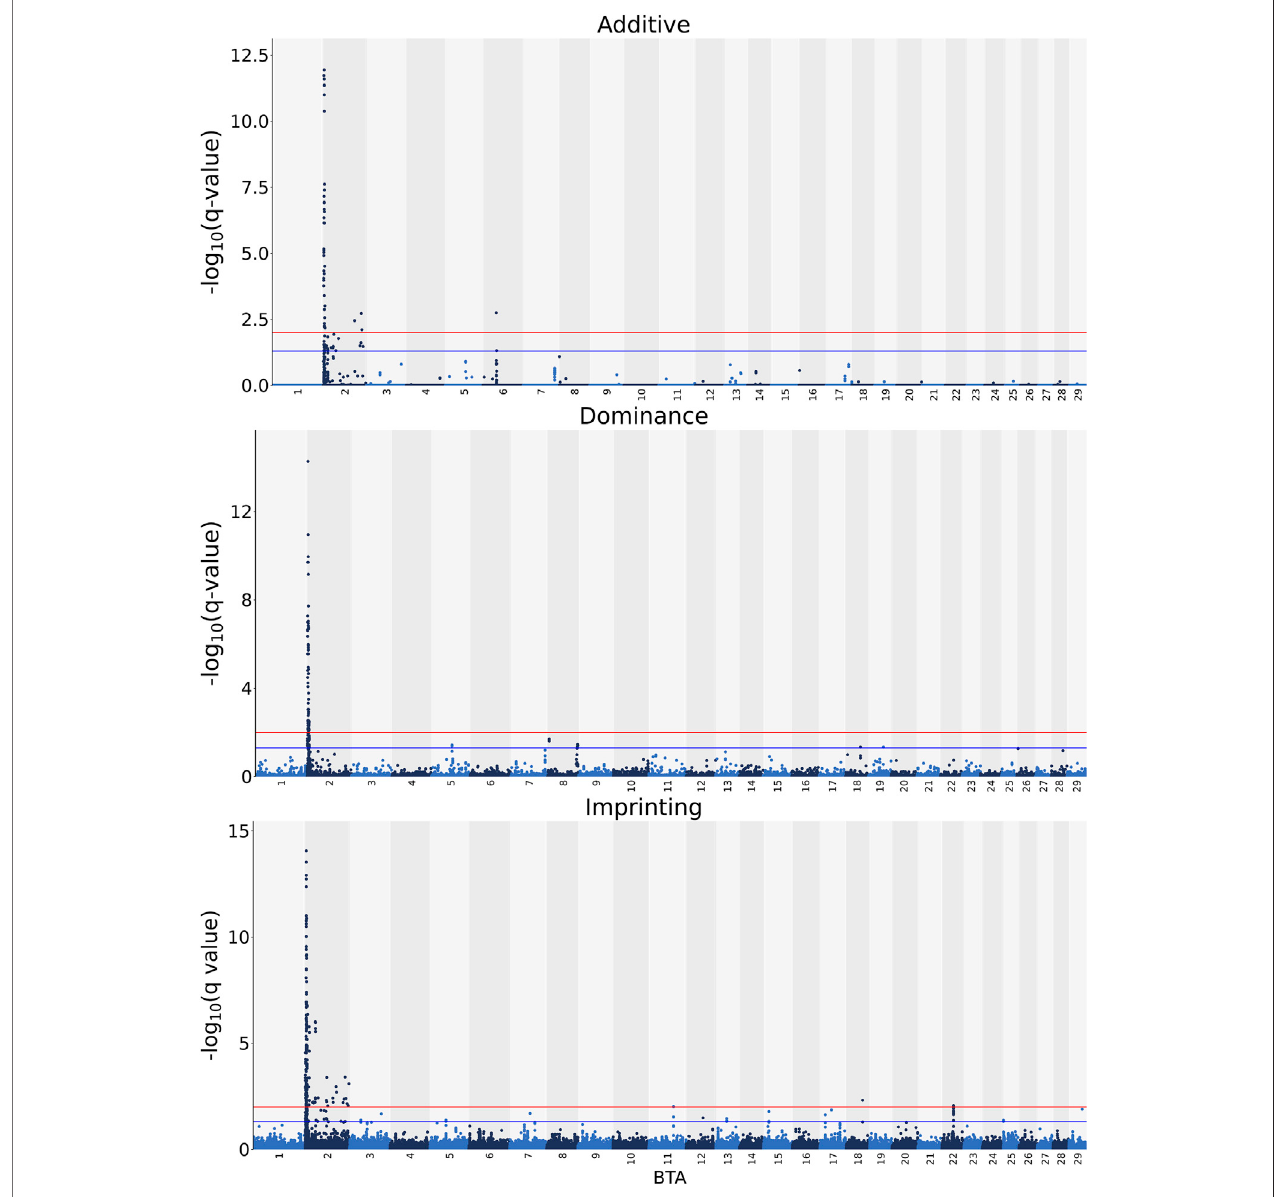
FIGURE3| Manhattanplotsofthe − log 10 (qvalues)foradditive,dominanceandimprintingassociationswithcarcassfatfromeach Bostaurus (BTA)chromosome. Blue and red lines are the thresholds for suggestive (0.01 < q value ≤ 0.05) and signi fi cant (q values ≤ 0.01) SNPs, respectively.